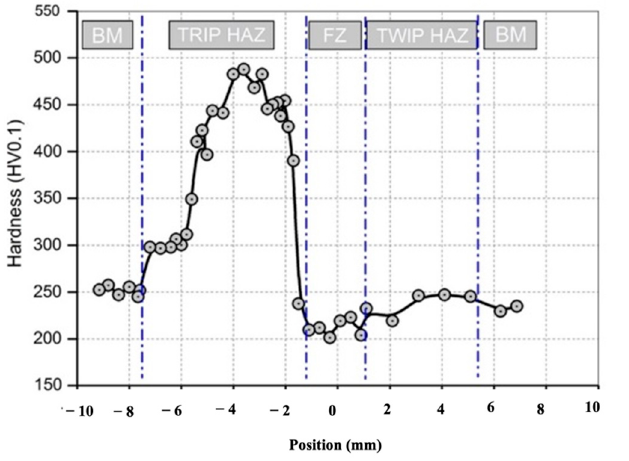
Figure 6. Microhardness of a TWIP–TRIP weld bead. Reprinted with permission from ref. [104]. Copyright 2016, Elsevier.